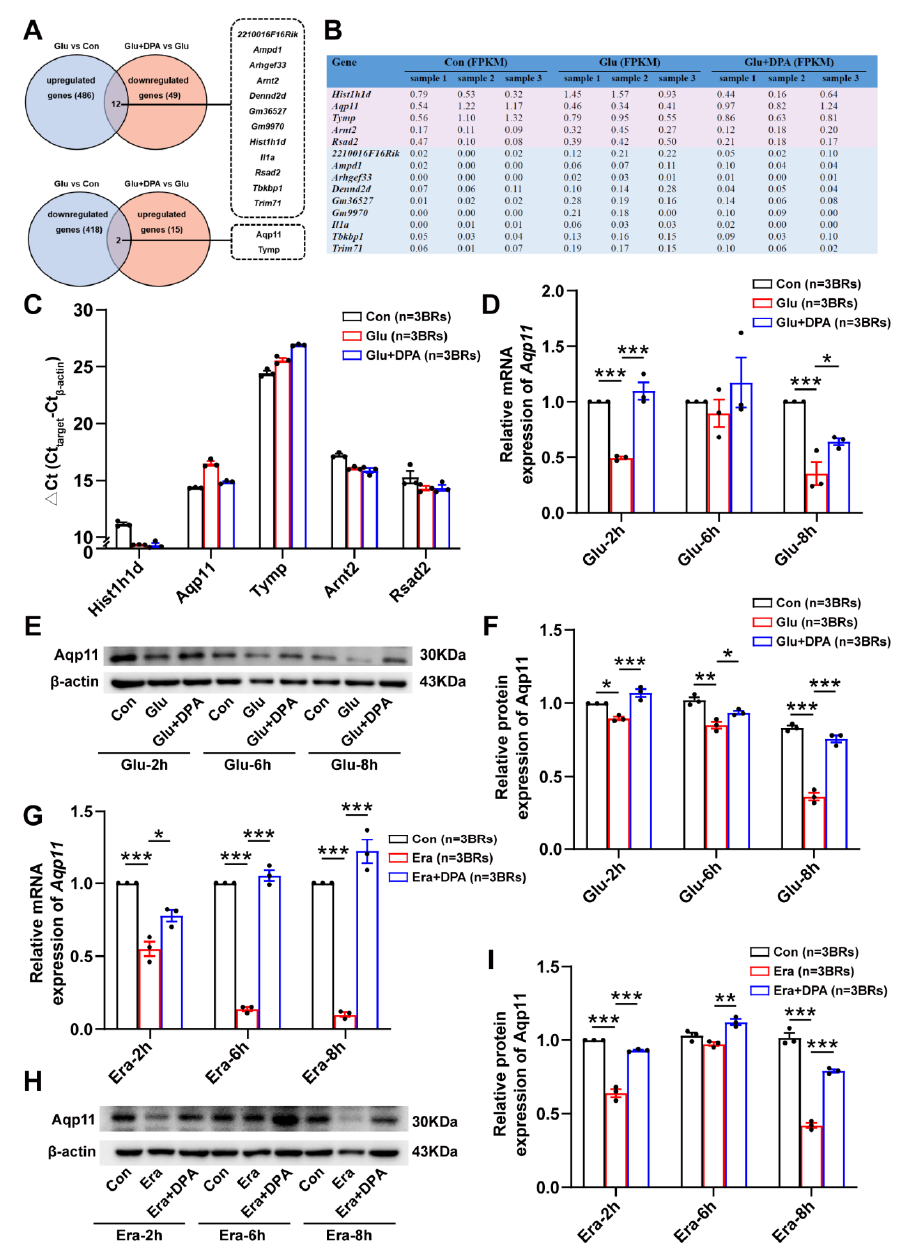
Figure 5. Aqp11 is a key target involved in the protection of DPA against ferroptosis in vitro. ( A ) Summary of differentially expressed genes in glutamate-induced neuronal ferroptosis in HT22 cells following DPA treatment. Cell samples were collected for RNA-seq analysis after DPA pretreatment with 10 μ g/mL for 2 h and glutamate challenge (5 mmol/L, 8 h). Totally, 14 differentially expressed genes or pseudogenes were screened, in which 12 genes or pseudogenes were up-regulated in glu- tamate group and were down-regulated in the combinational treatment with glutamate and DPA, while other 2 genes were down-regulated in glutamate group and were up-regulated in the